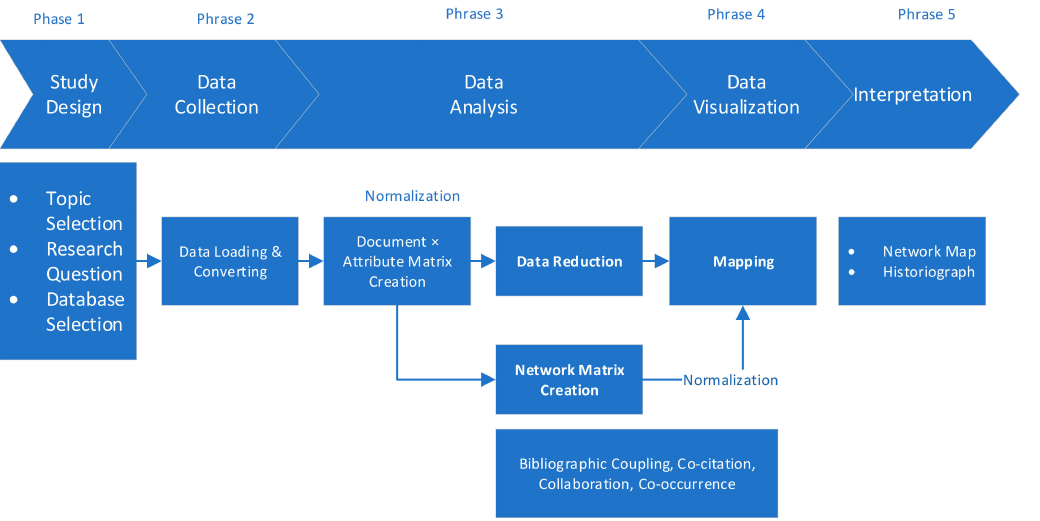
Figure 1. Schematic of the bibliometric analysis methodology adapted with permission from Refs. [57,58]. Copyright 2017, Aria and Cuccurullo, and copyright 2020, Silvana et al.